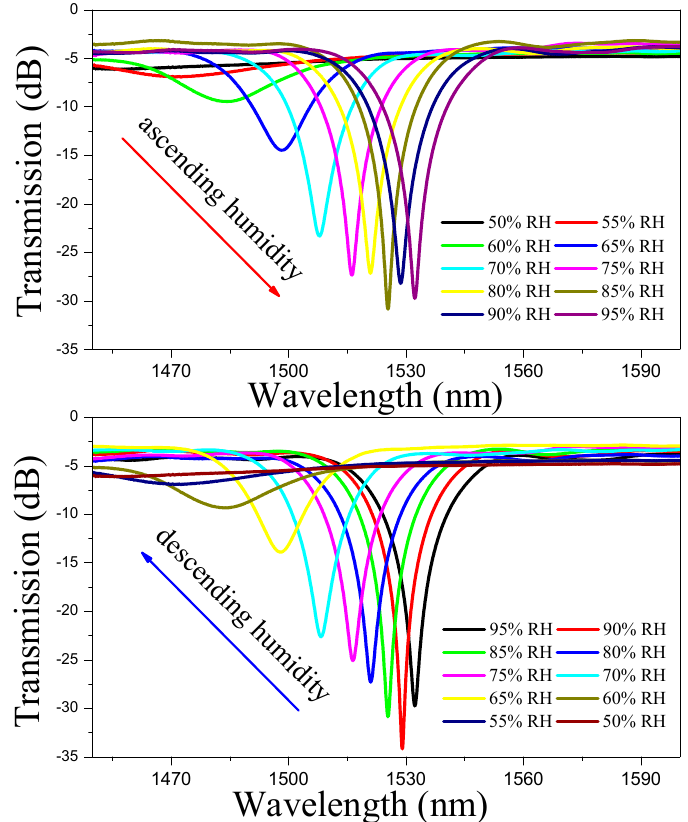
Figure 6. The transmission spectra of the coated LPFGs with a PEG proportion of 2/3 when the relative humidity is ascending and descending.